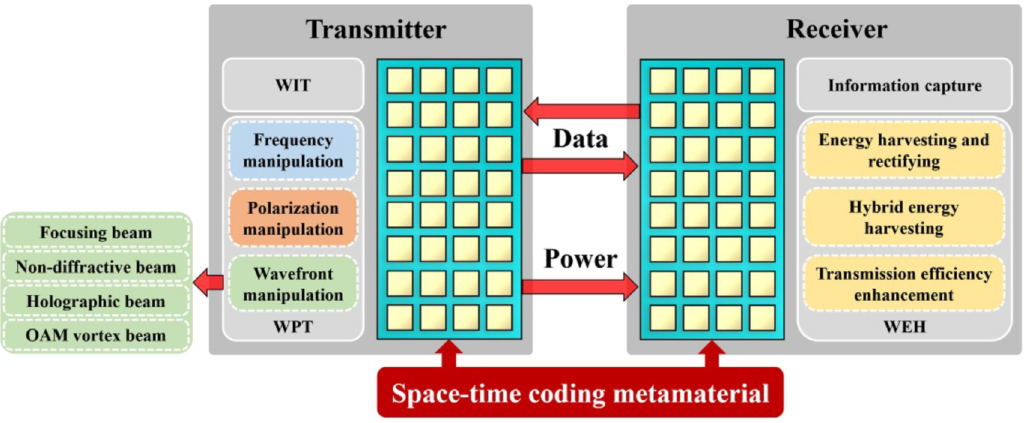
Figure 27: The STCM for